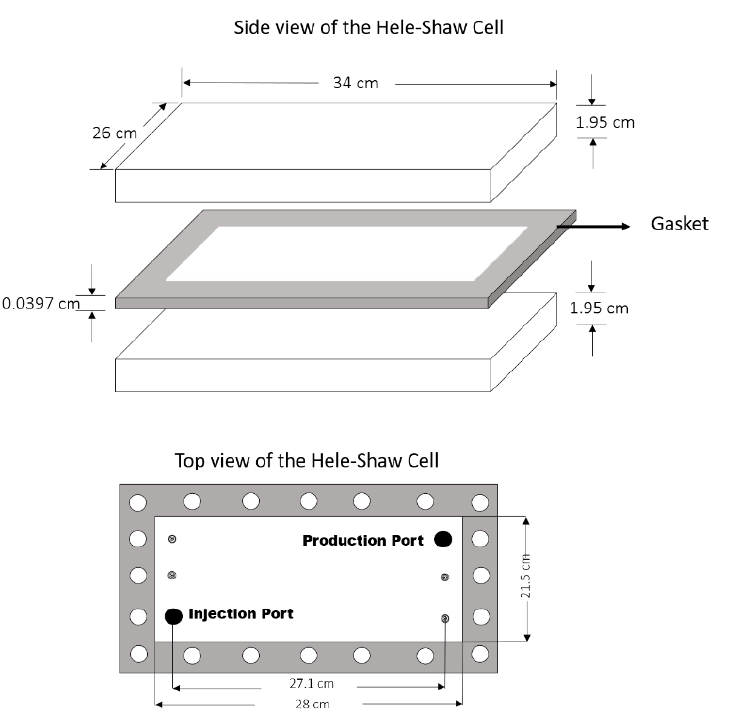
Figure 2. Hele-Shaw dimensions.